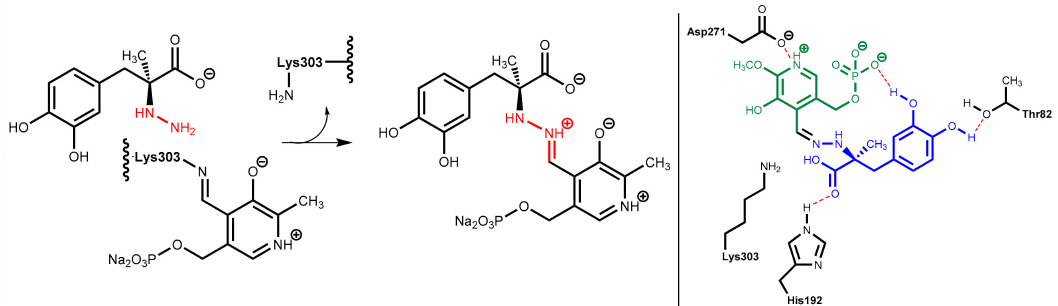
Figure 26. ( Left ): Carbidopa forms a hydrazine (highlighted in red) with the pyridoxal phosphate in the active site of DOPA decarboxylase. ( Right ): This hydrazine (carbidopa fragment highlighted in blue, pyridoxal fragment in green) is bound in the active site via numerous polar